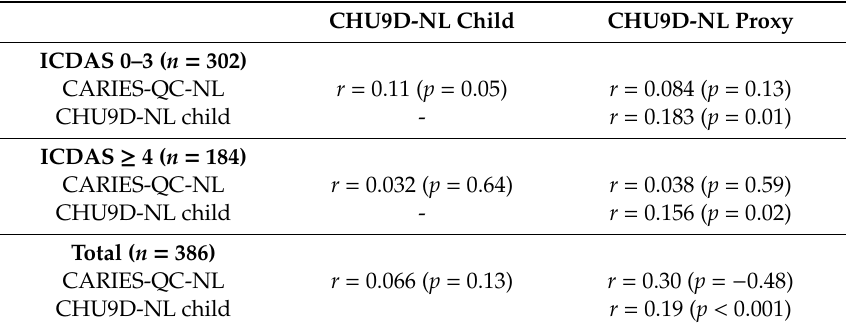
Table 5. Bivariate correlations between CARIES-QC-NL total scores and CHU9D-NL utility scores in ICDAS 0–3 and ICDAS ≥ 4